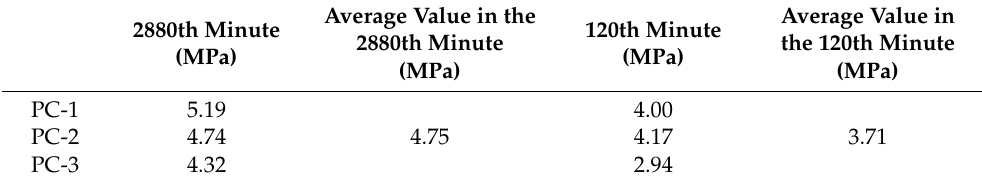
Table 5. Lateral restricted-swelling